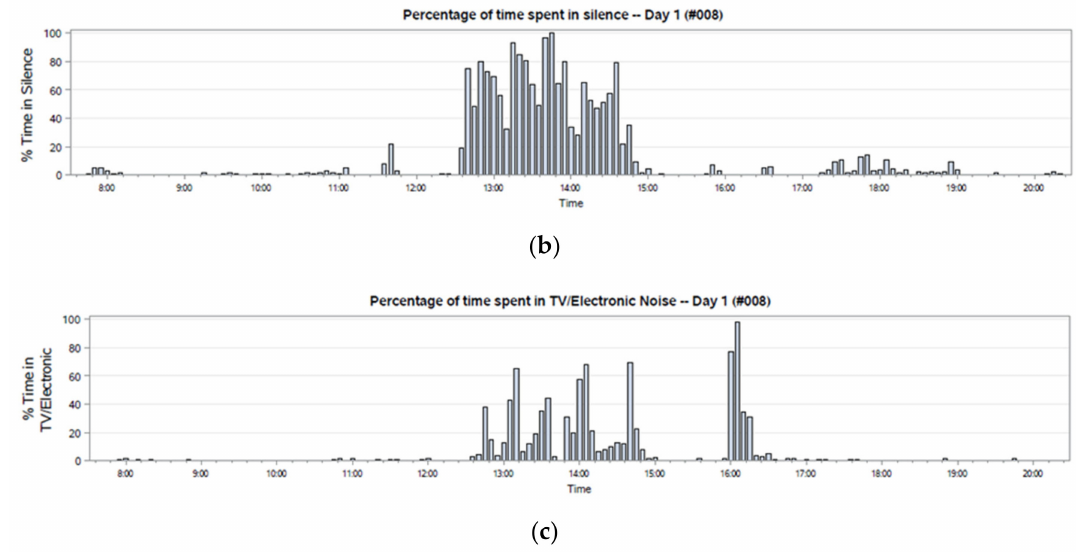
Figure 6. Bar graph of LENA data, specifically the percentage of time the recording was primarily noise ( a ), silence ( b ), and TV / Electronic noise ( c ) averaged across 5 min. Data are included for the day 1 recording for participant